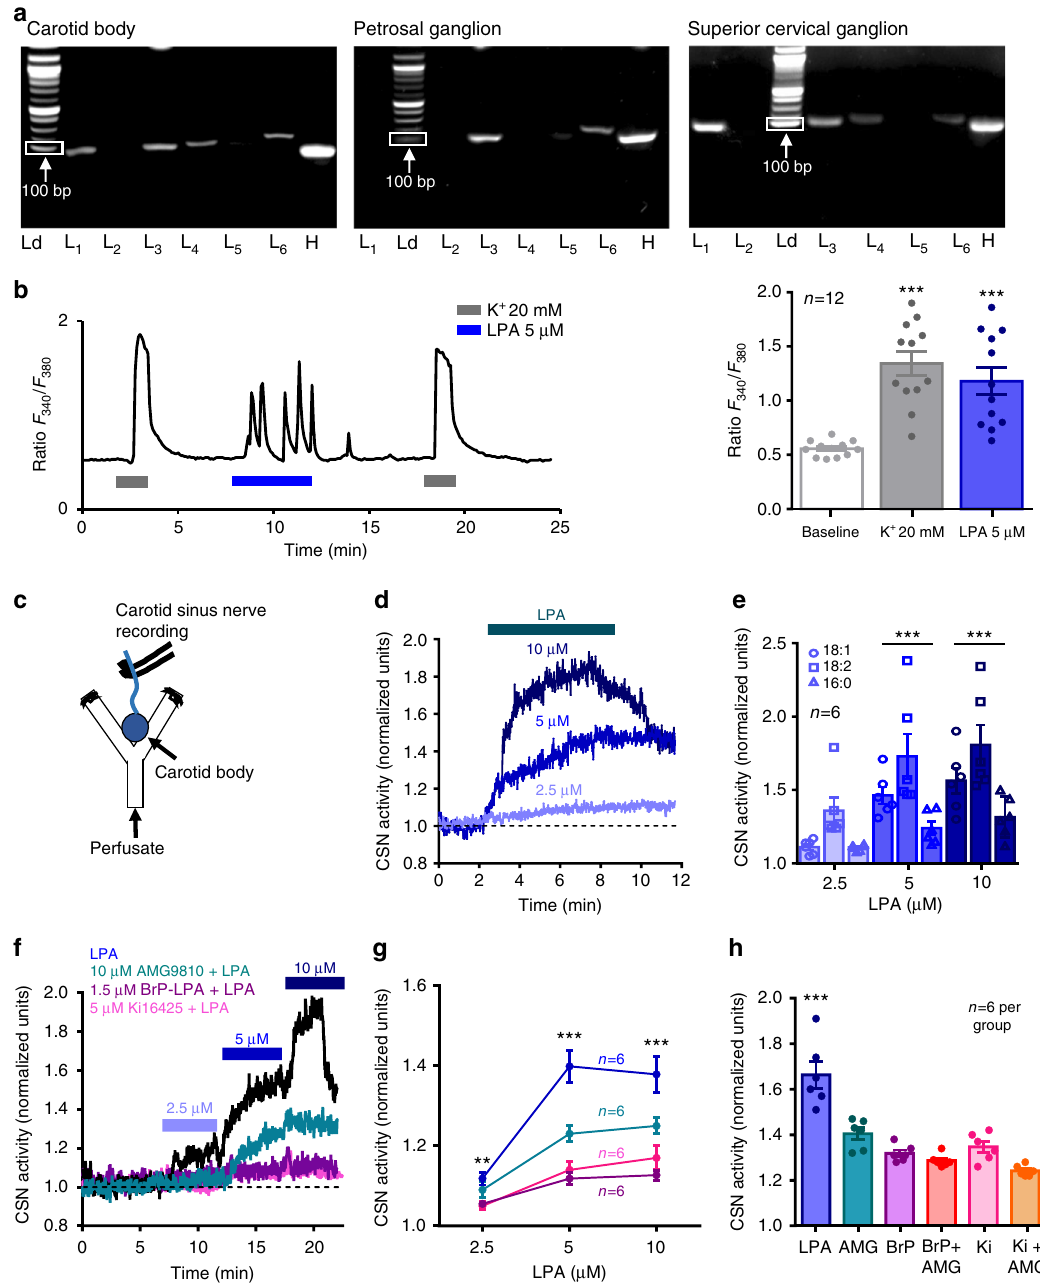
Fig. 1 LPA stimulates the carotid body. a RT-PCR: LPAr (L) 1, 3, 4, and 6 in carotid body (left), LPAr 3 and 6 in petrosal ganglia (center), and LPAr 1, 3, 4, and 6 in superior cervical ganglia (right) in reference to a housekeeping gene, hypoxyribosyltransferase (H; cDNA ladder, Ld, was used to identify tissues used for each gel, 100 bp marker indicated). b Calcium imaging with Fura-2 loaded carotid body glomus cells (12 cells on 5 cover slips) reveals an increase of intracellular calcium in response to 5 µ M LPA (18:1 unless otherwise stated) and 20 mM K + . F 2,35 (one-way ANOVA) = 18.220, p < 0.001; Holm – Š idák post hoc: difference from baseline, *** p < 0.01. c En bloc perfused carotid body preparation used to record chemosensory afferents in the carotid sinus nerve (CSN). d LPA 18:1 causes an increase in CSN activity. e The dose-dependent relationship differed slightly between several species of LPA found in blood (16:0, 18:1, and 18:2); F 4,53 (two-way ANOVA: species × dose) = 3.380, p = 0.021. Holm – Š idák post hoc: all species 5 and 10 µ M different from 2.5